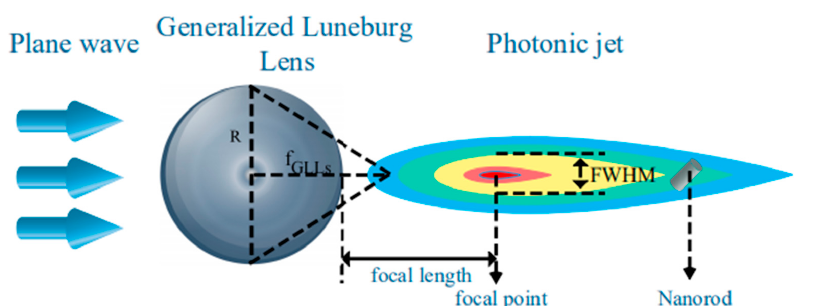
Figure 3. PJ generated by a plane wave illuminating a GLLs. In the figure, plane waves, GLLs, photonic jets, and nanorods and some of their parameters (such as the maximum radius R and the focal length f GLLs of GLLs, the focal point of the photonic jet, the focal length f and FWHM ) are marked respectively. GLLs are composed of 30 layers of concentric rings with different refractive indexes centered on the center of the sphere.